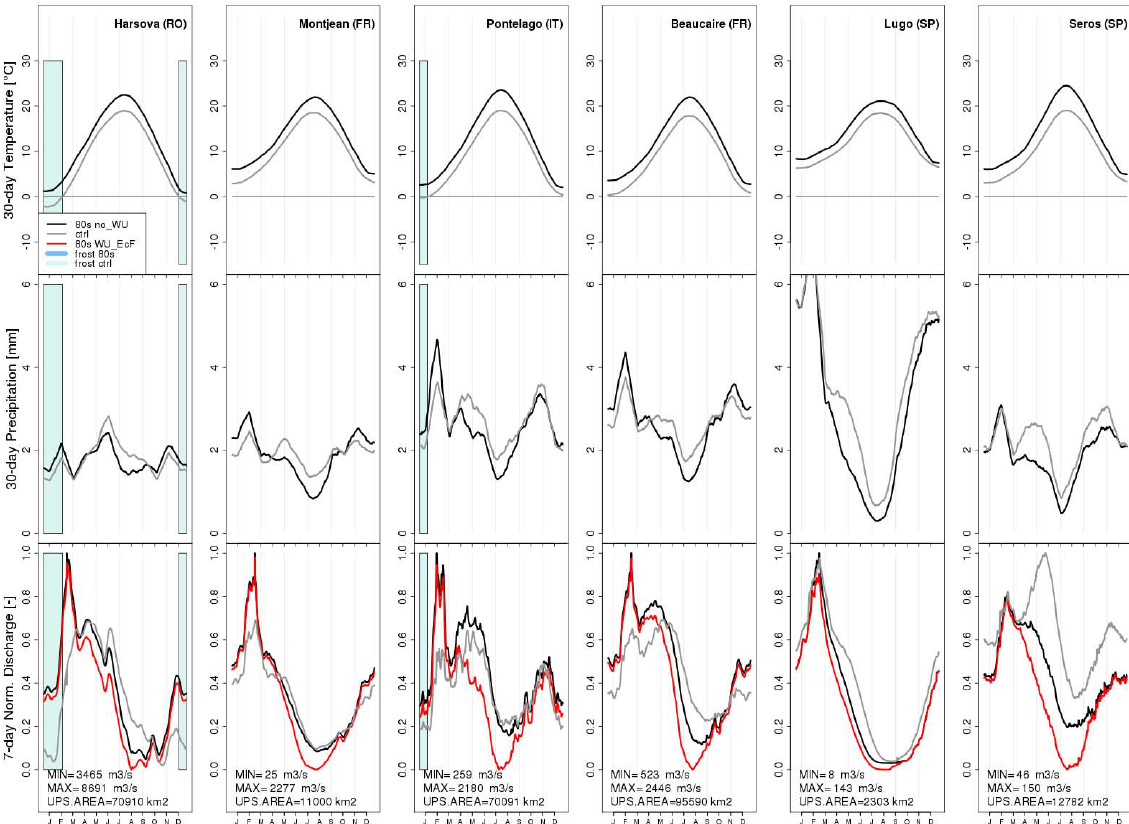
Fig. 6. As Fig. 5, for different